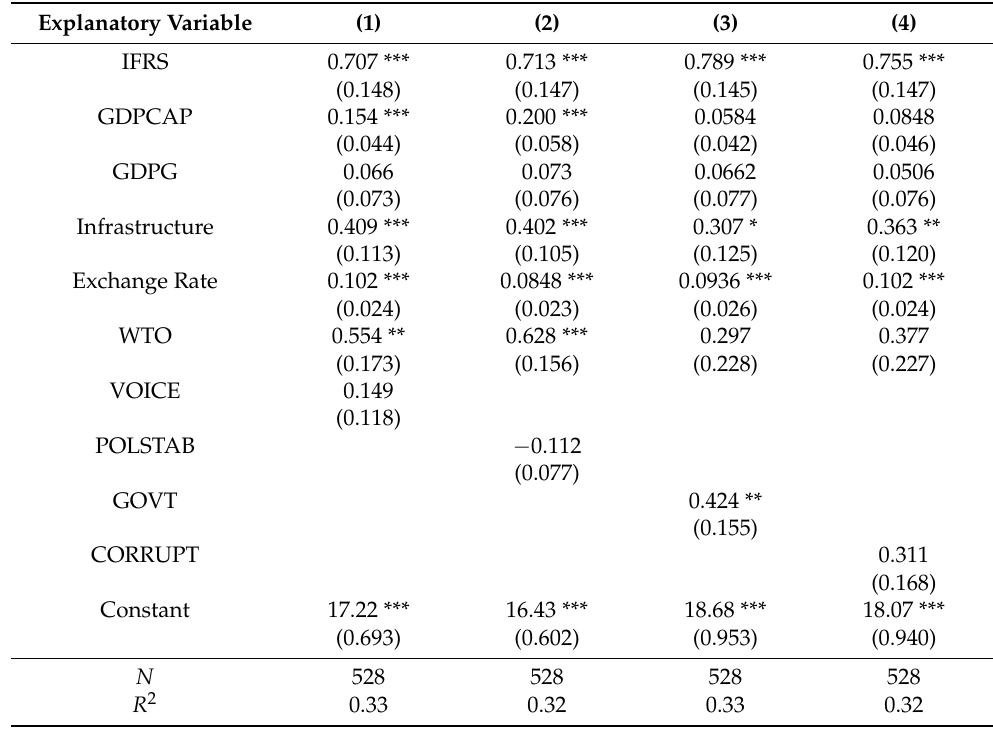
Table 3. PPML estimation results with individual time effects.